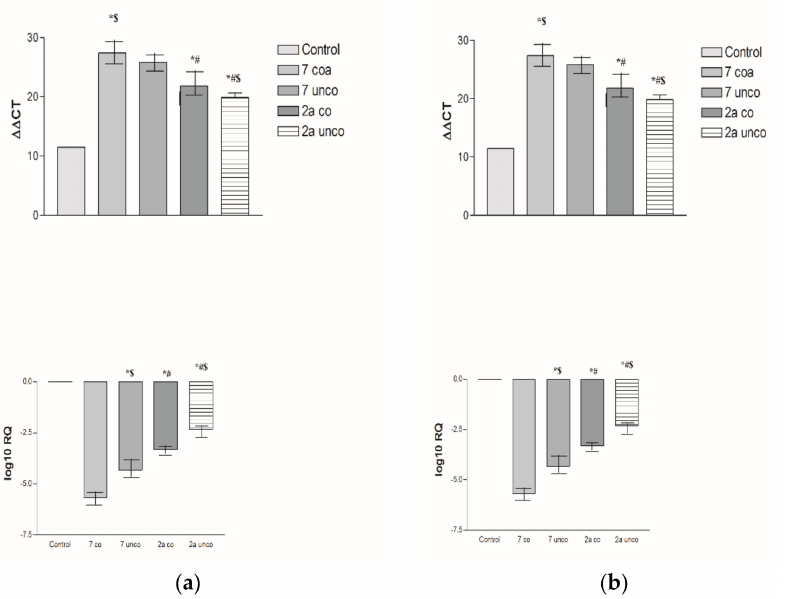
Figure 23. Effects of 2a - and 7 -loaded niosomes (F2 and S2) either being coated with TPGS versus the uncoated ones on VEGF gene expression level (( a ) HepG2 and ( b ) MCF-7). All therapies were provided for 3 successive days. Results are given as mean ± S.E.M. The difference in ∆∆ CT readings is among all treated groups. Average fold decrease of VEGF gene expression is on a log scale. * p ≤ 0.05 vs Control, # p ≤ 0.05 vs 7 coa, $ p ≤ 0.05 vs 7 uncoa, p ≤ 0.05 vs 2a uncoa.